Question: Compose a caption that would accompany this figure in a paper.
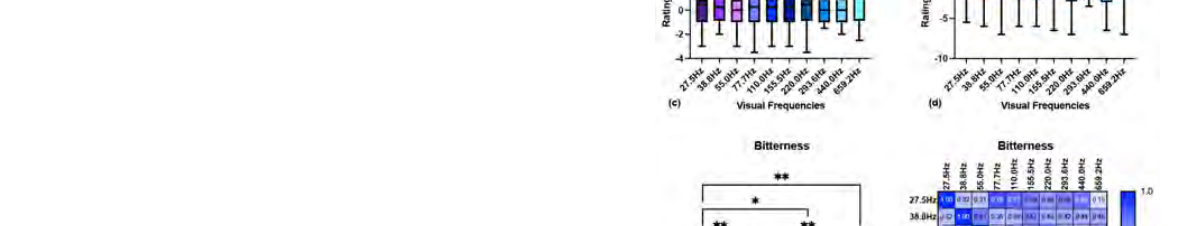
Answer: The process of user study 1